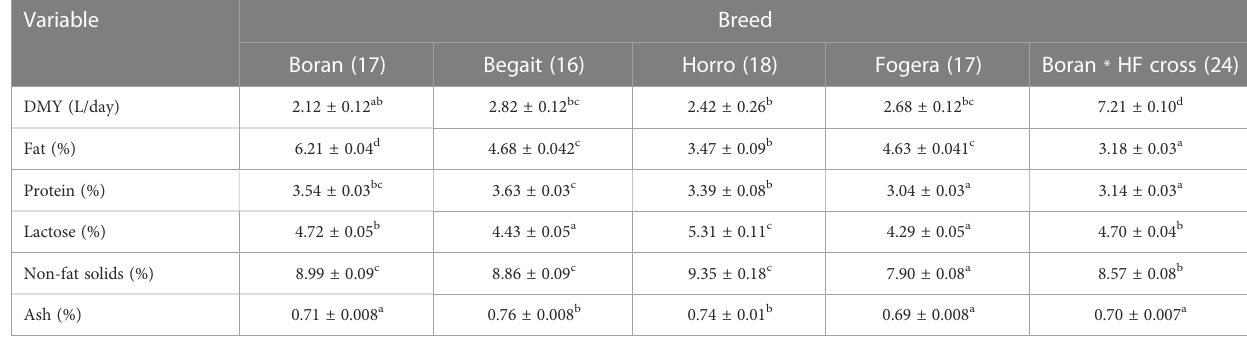
TABLE 1 Effect of breed on DMY and milk composition traits in Ethiopian